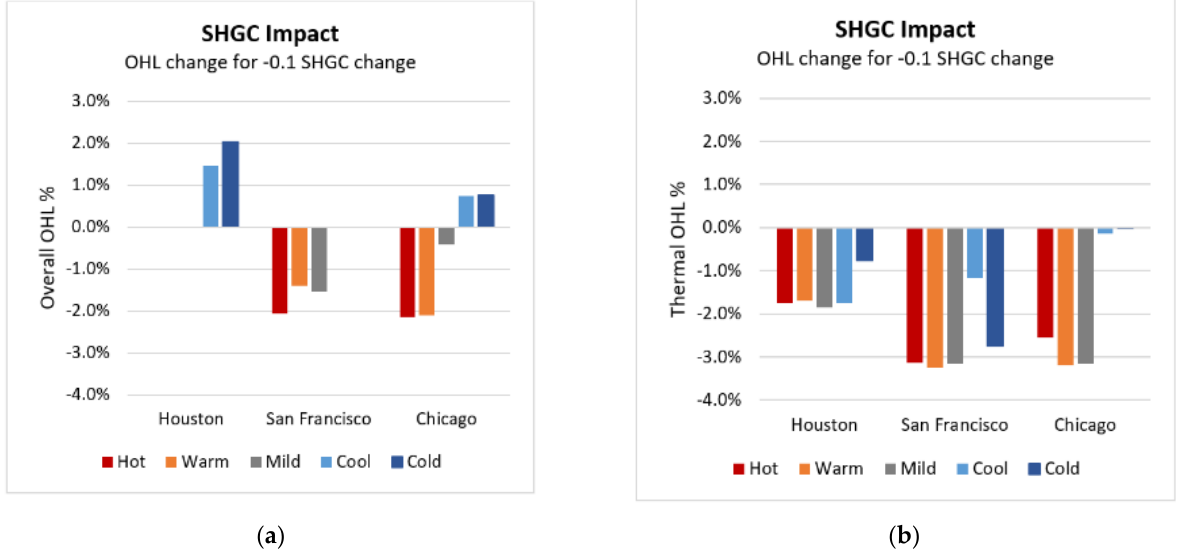
Figure 8. Impact of a 0.1 decrease in SHGC on overall ( a ) and thermal ( b )